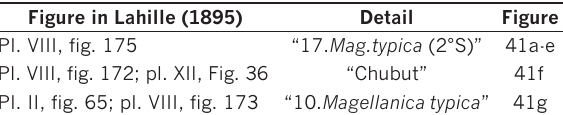
Table 16. Specimens of Voluta magellanica typica figured in Lahille (1895) with the detail of the inscriptions on their shells and figures here.